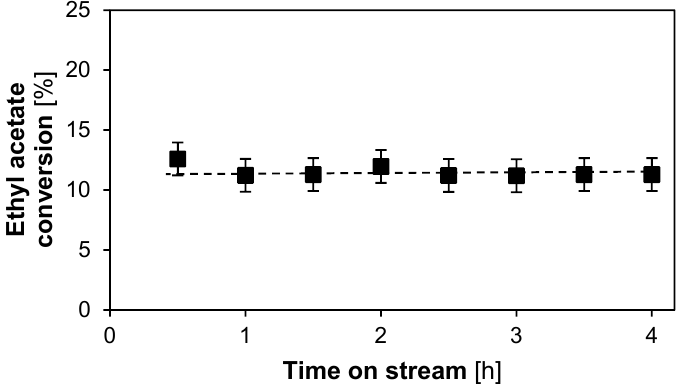
Figure 4. Conversion in function of time on stream for the transesterification between methanol and ethyl acetate using n-octane as a solvent. Lewatit K 2629 catalyst, T = 60 ◦ C, P tot = 180 kPa, site time = 15.75 mol site s mol − 1 , 19.8 wt % ethyl acetate, 71.4 wt % methanol, 8.8 wt % octane (internal standard). Fixed error of 1.4%.